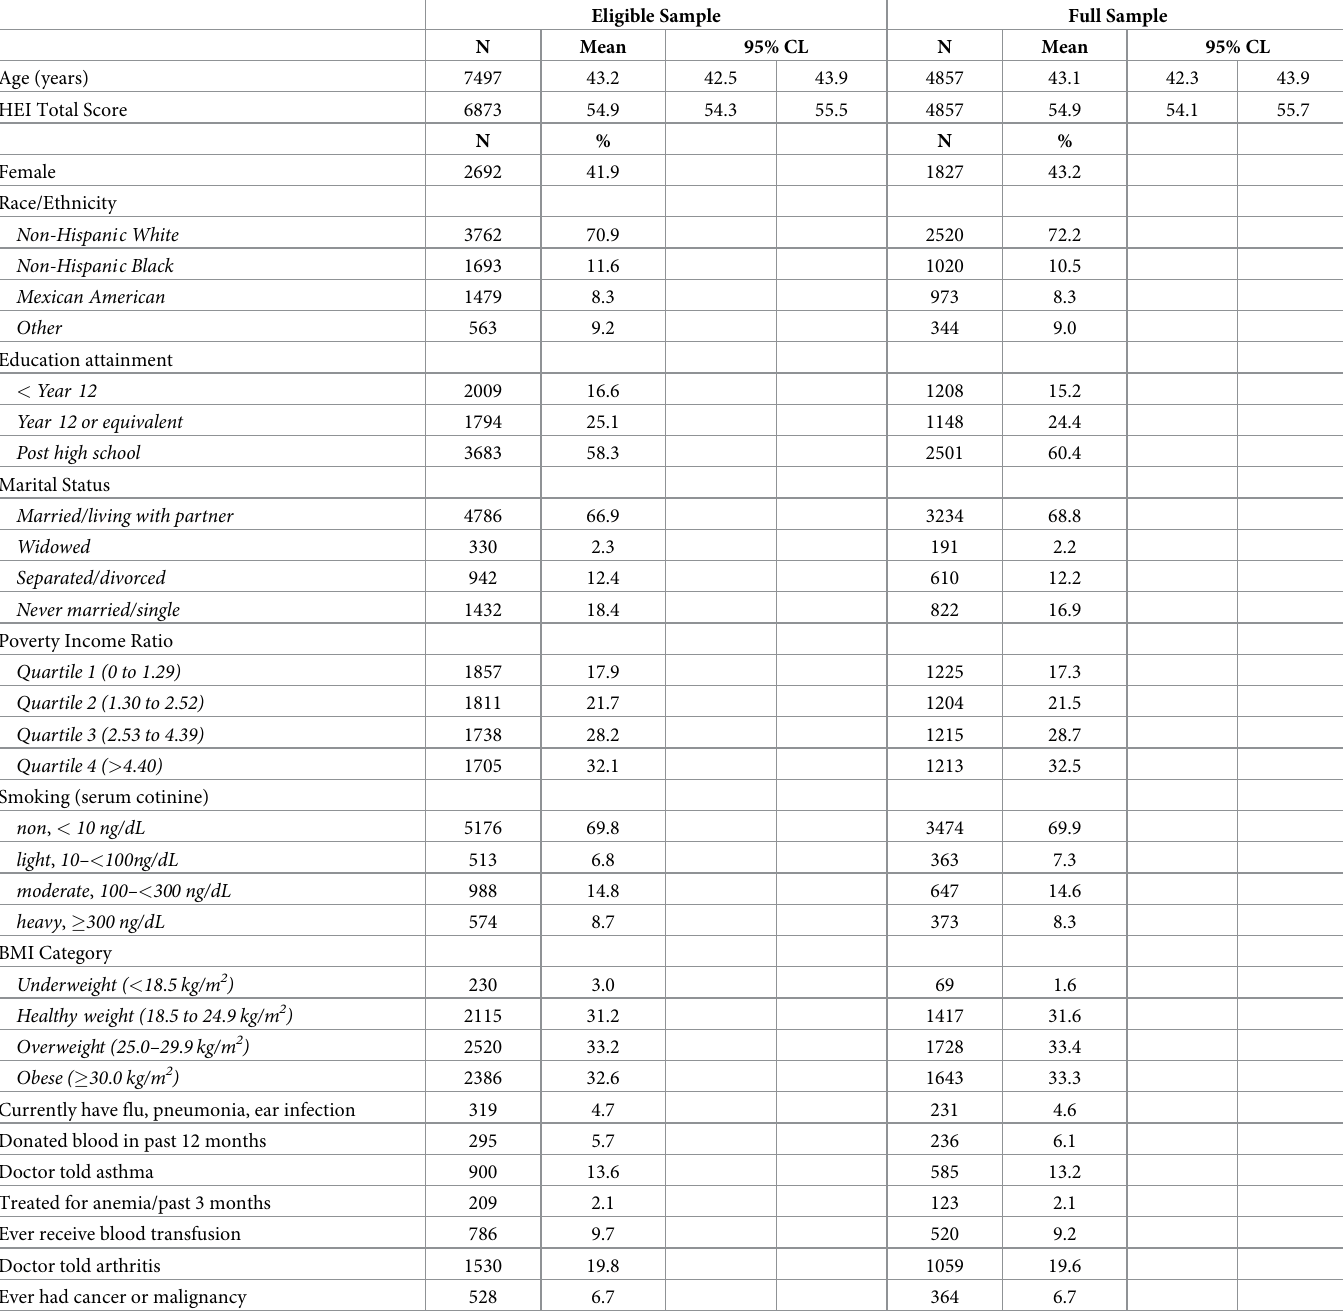
Table 2. Population-weighted characteristics of the eligible sample and the full sample of U.S. adults (cid:21) 20 years (NHANES 2003–2006). Eligible